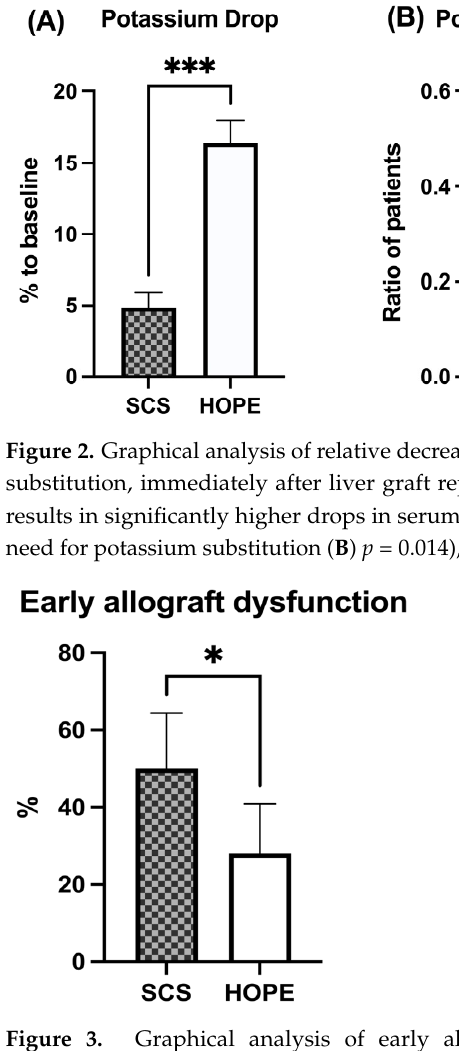
Figure 3. Graphical analysis of early allograft dysfunction in liver transplant recipients (Mean ± 95% ‐ CI). HOPE preconditioning results in significantly lower incidence of EAD within the first seven postoperative days, as compared to SCS. (* = p < 0.05)